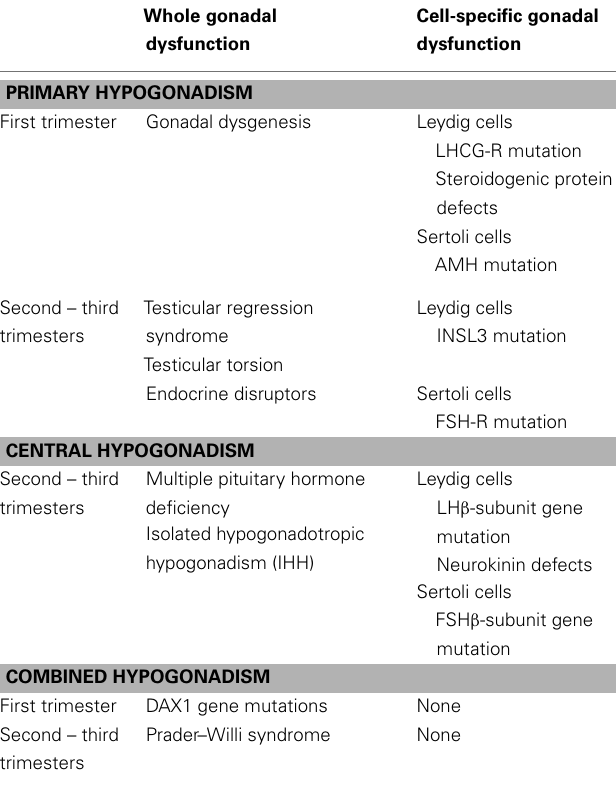
Table 1 | Classification of fetal-onset male